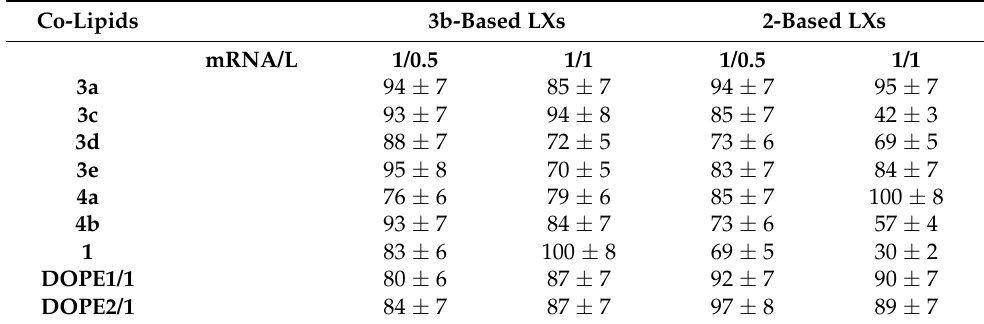
Table 4. Cell Viability (%) in the presence of mRNA